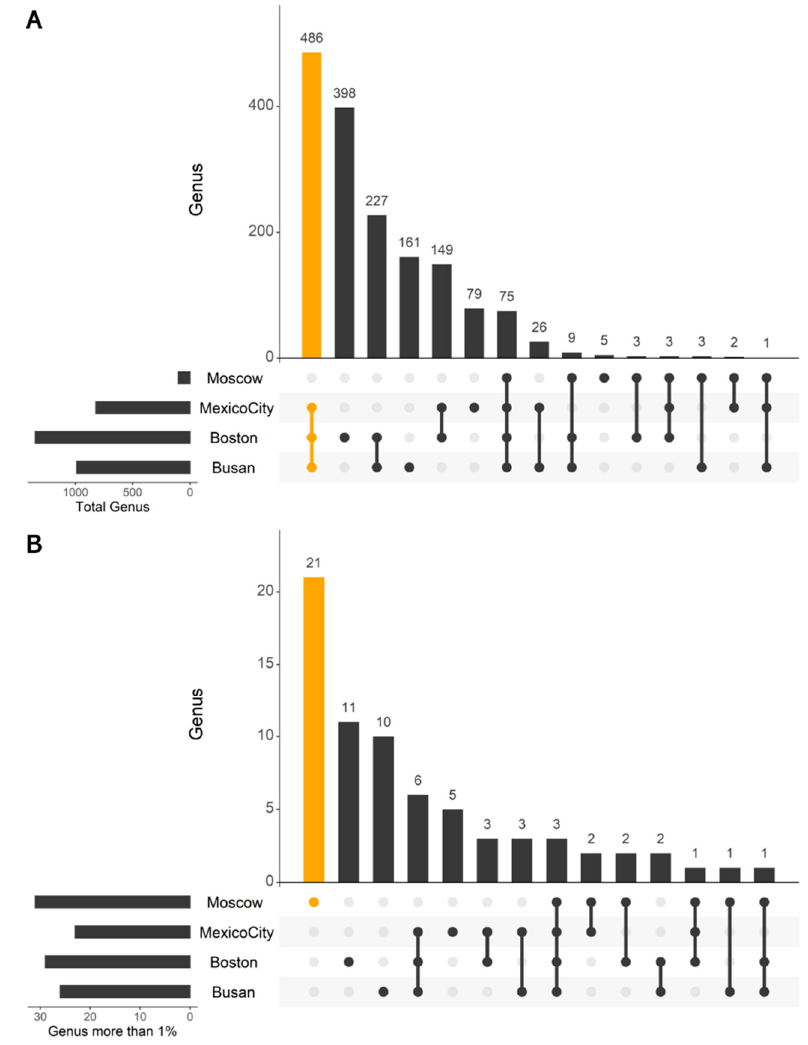
Figure 4. Upset plots of the bacterial genera among the cities. The plot was illustrated by ( A ) total genus and ( B ) genus more than